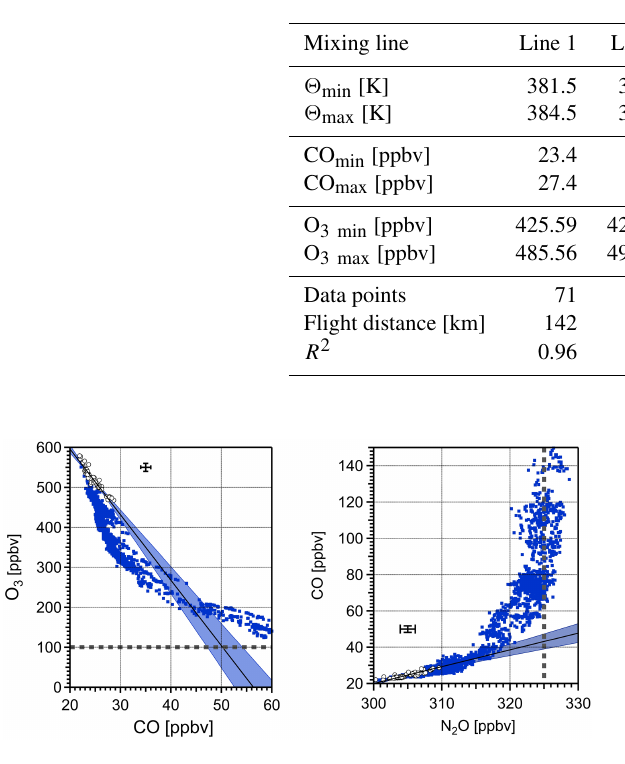
Figure 4. Linear fits for ML 4 based on the FITEXY routine de- scribed in Press et al. (1992). Blue dots: scatter plot of CO and O 3 (left) as well as N 2 O and CO (right). Circles: individual data points forming the mixing line ML 4. Solid black line: linear fit with confidence region (shaded area). Dotted lines indicate typi- cal tropopause mixing ratios for O 3 and N 2 O to determine the tro- pospheric mixing line “end member” ( R (O 3 ) Trop = 100ppbv (top) and R (N 2 O) Trop = 25ppbv (bottom)). Uncertainties are separately shown as black